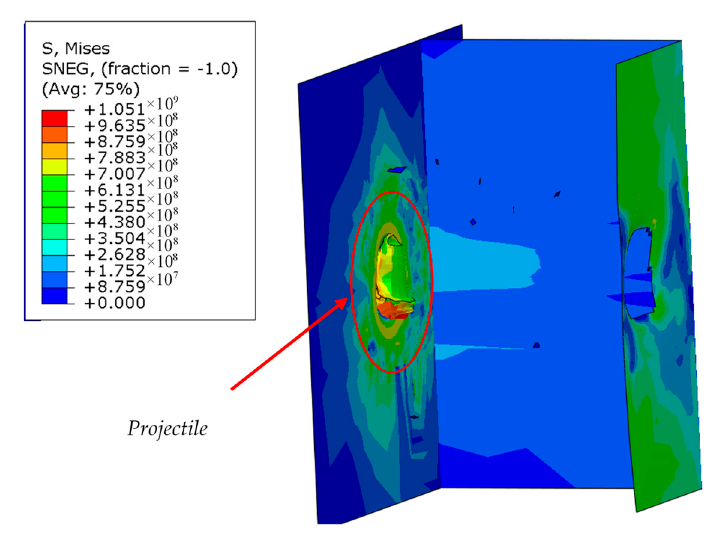
Figure 13. Side hitting projectile due to the torque from the impact at an angle.